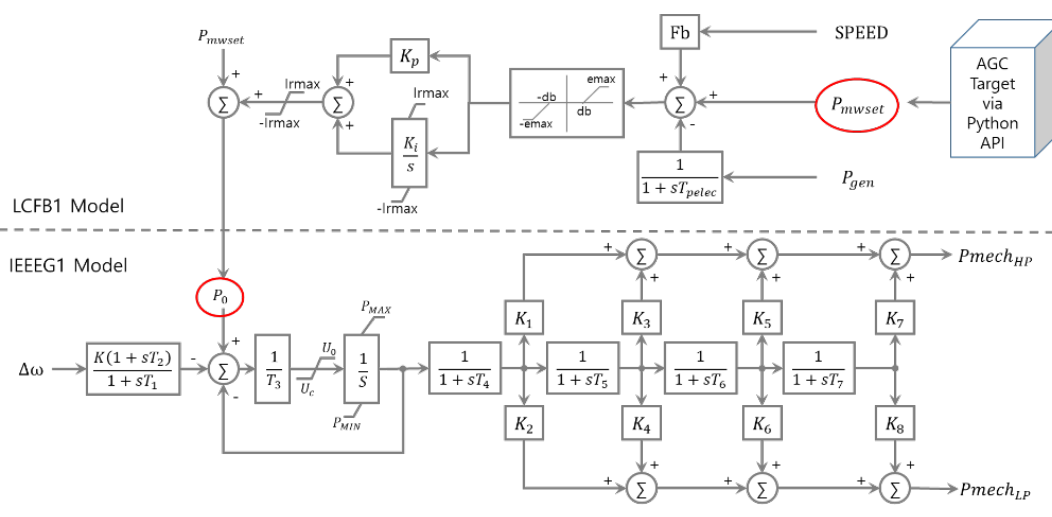
Figure 7. IEEEG1 model interfacing with the LCFB1 model for simulating AGC.